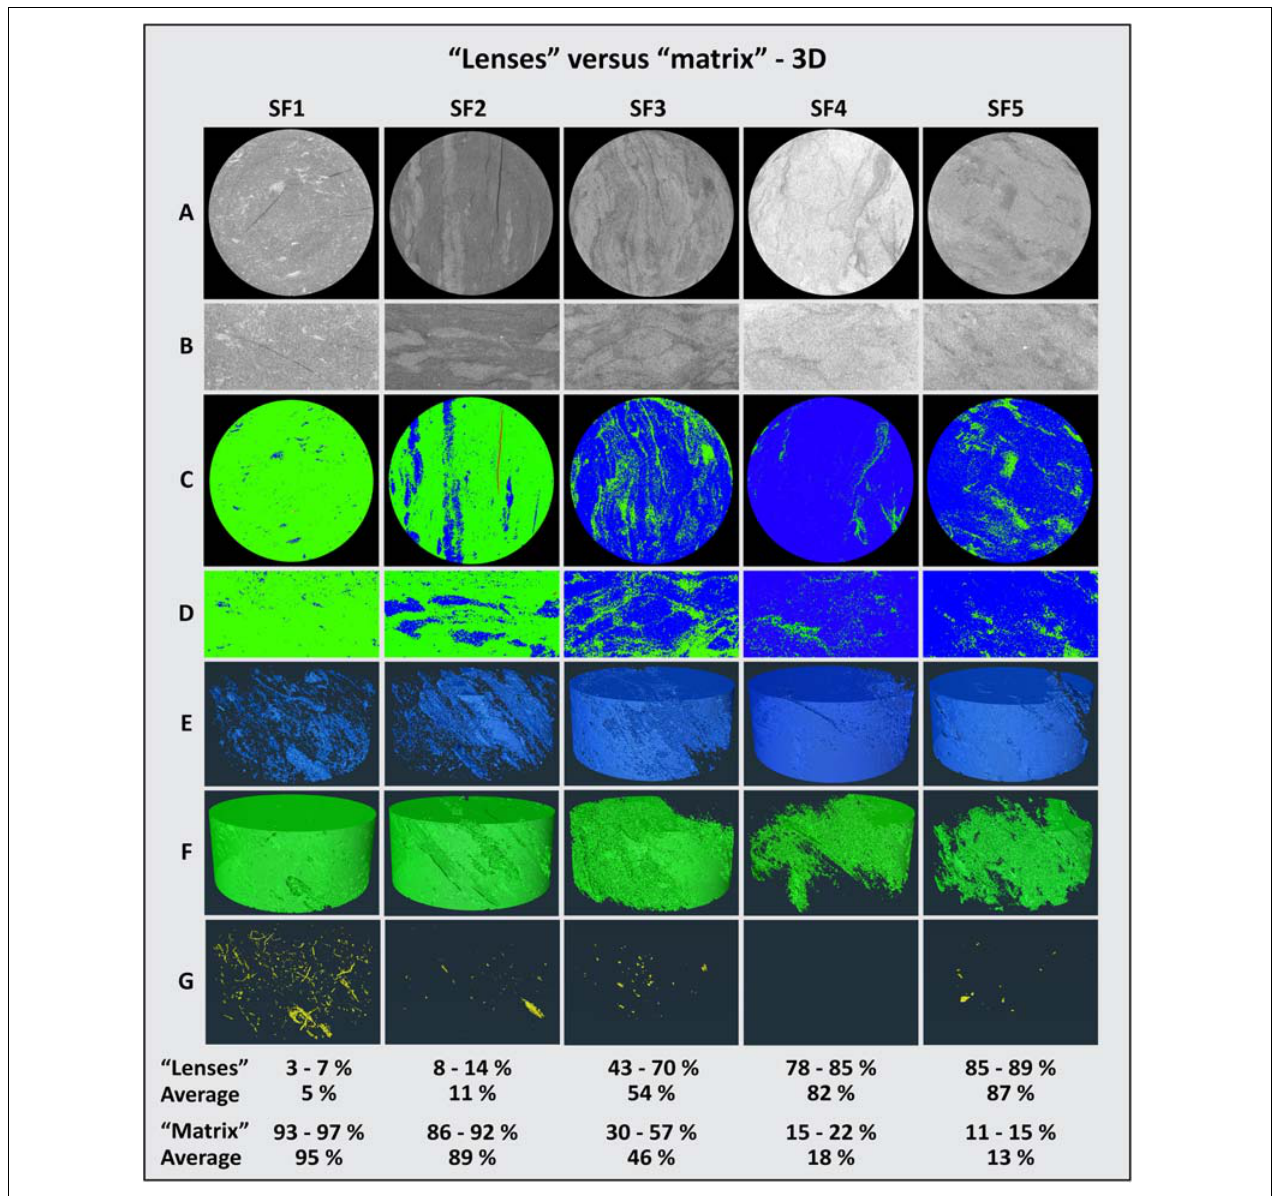
FIGURE 10 | Selected results of µ -CT scans of core intervals (BMB-A6) displaying individual subfacies types. (A) Representative 2D xy slices (raw data) of the analyzed core intervals (selected core diameter = 5.50 cm). (B) Representative 2D yz plane slices (raw data) of selected core intervals (y = 5.50 cm; z = 2.35 cm). (C) Segmented data of the same 2D xy slices as in panel. (D) Segmented data of the same 2D yz slices as in panel. (E) Representative 3D volumes of “lenses” (mainly carbonate + quartz) for each subfacies type. (F) Representative 3D volumes of “matrix” (mainly clay minerals) for each subfacies type (same areas as 2D images, except for SF3). (G) Representative 3D volumes of pyrite content (high density contrasts) for each subfacies type. Green, “matrix”; blue, “lenses”; yellow, pyrite. For ease of convenience during the segmentation process, 2 to 3 distinct sub-sections from each selected core interval were individually segmented. The individual sub-sections were subdivided into 55- µ m-thick slices (varying between 426 and 511 slices, depending on sub-section), which were segmented into three materials (“matrix,” “lenses,” and pyrite) and porosity. “Lenses” and pyrite were summed up together within the final “lenses” content for percentage calculations. Indicated “lenses” and “matrix” range and average values reflect the variation between the individual sub-sections in each subfacies type core interval. Bedding plane in the BMB-A6 core shows an angle of about 43 ◦ with respect to drilling